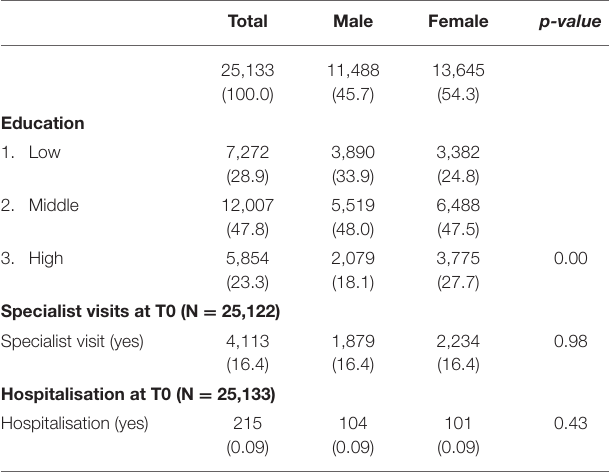
TABLE 1 | Sample characteristics and secondary healthcare use at retirement in total numbers (and